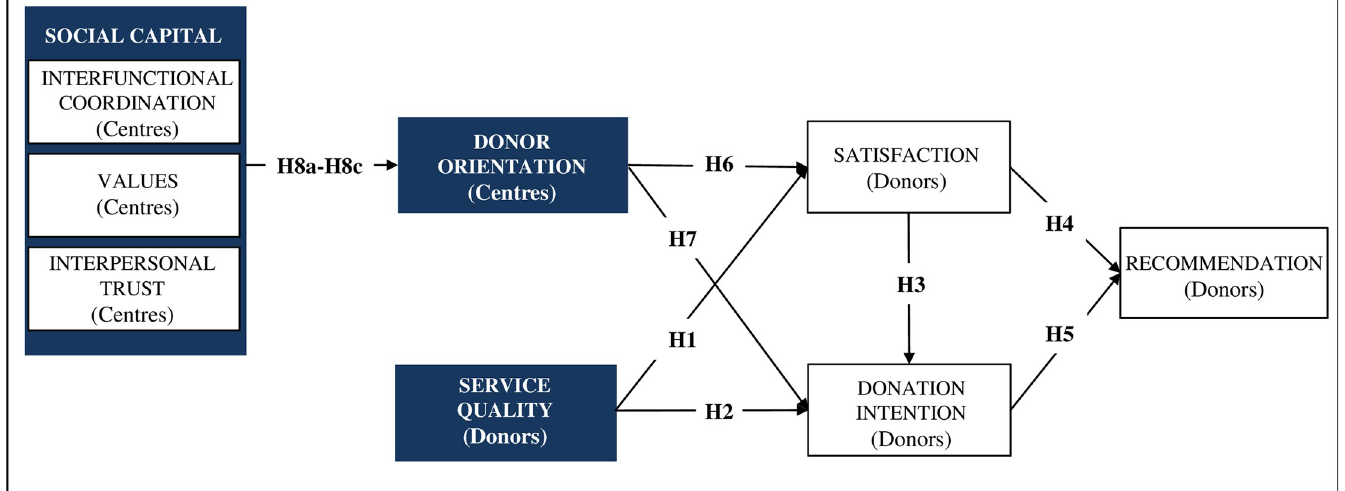
Fig 1. Management model for blood transfusion centres. Note: In each construct, the source of information to be used has been added in parentheses (centre staff or active donors).